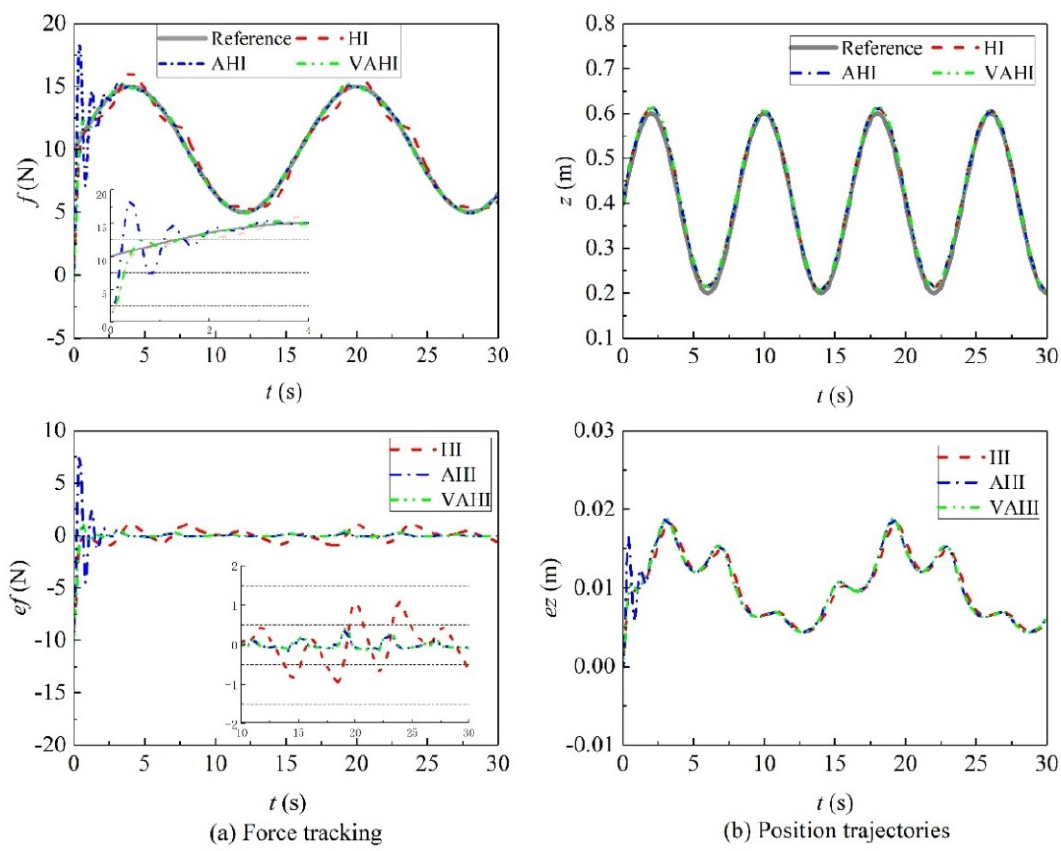
Figure 10. Tracking of the varying force with HI, AHI, and VAHI control schemes in the sine surface.